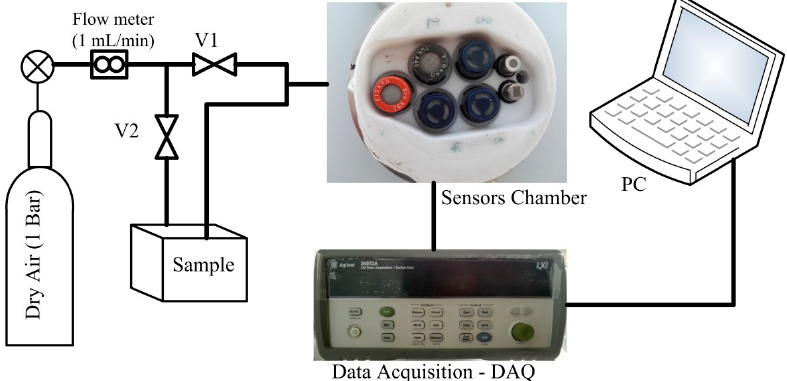
Figure 2. Schematics of an electronic nose based on seven metal oxide sensors (MOS).